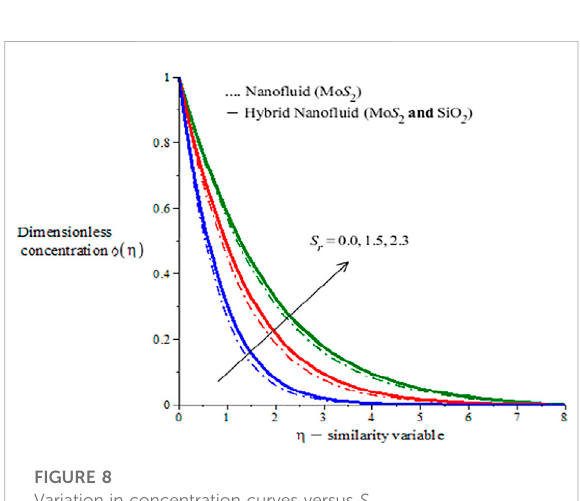
FIGURE 7 Variation in thermal curves versus D f .